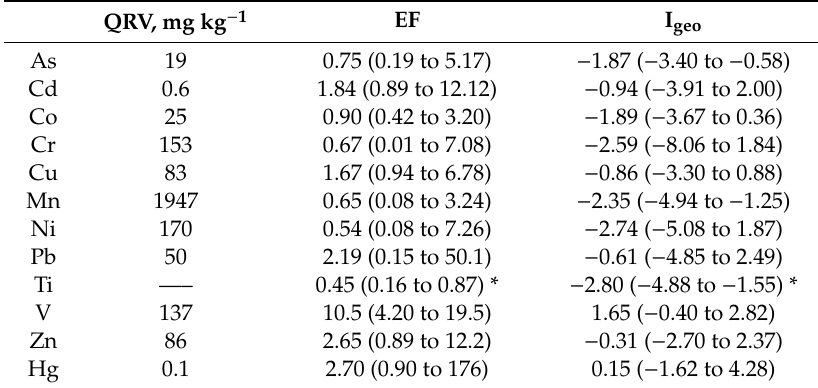
Table 8. Quality reference values (QRVs) established by Rodriguez Alfaro et al. (2015) for Cuban soils, enrichment factors (EF) and geoaccumulation indices (I geo ) calculated for the urban soils studied by comparison with these QRVs (median and interval in